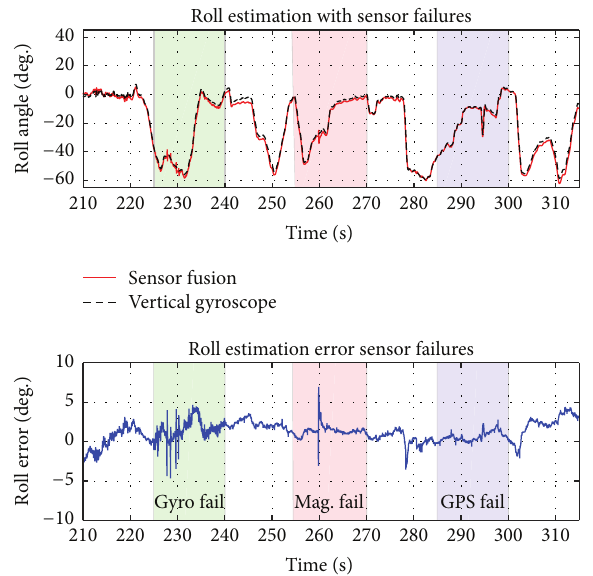
Figure 5: Rejection of low-quality GPS measurements by the sensor fusion algorithm.